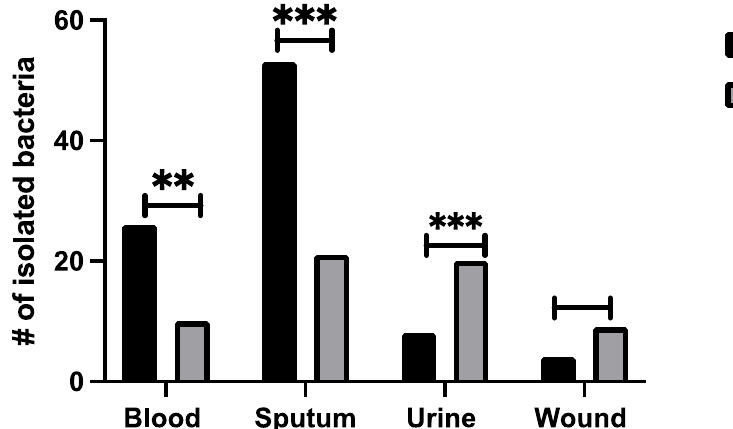
Figure 1. The numbers of bacterial isolates identified in different types of samples collected from ICU and non-ICU COVID-19 patients; ** p < 0.01, *** p <